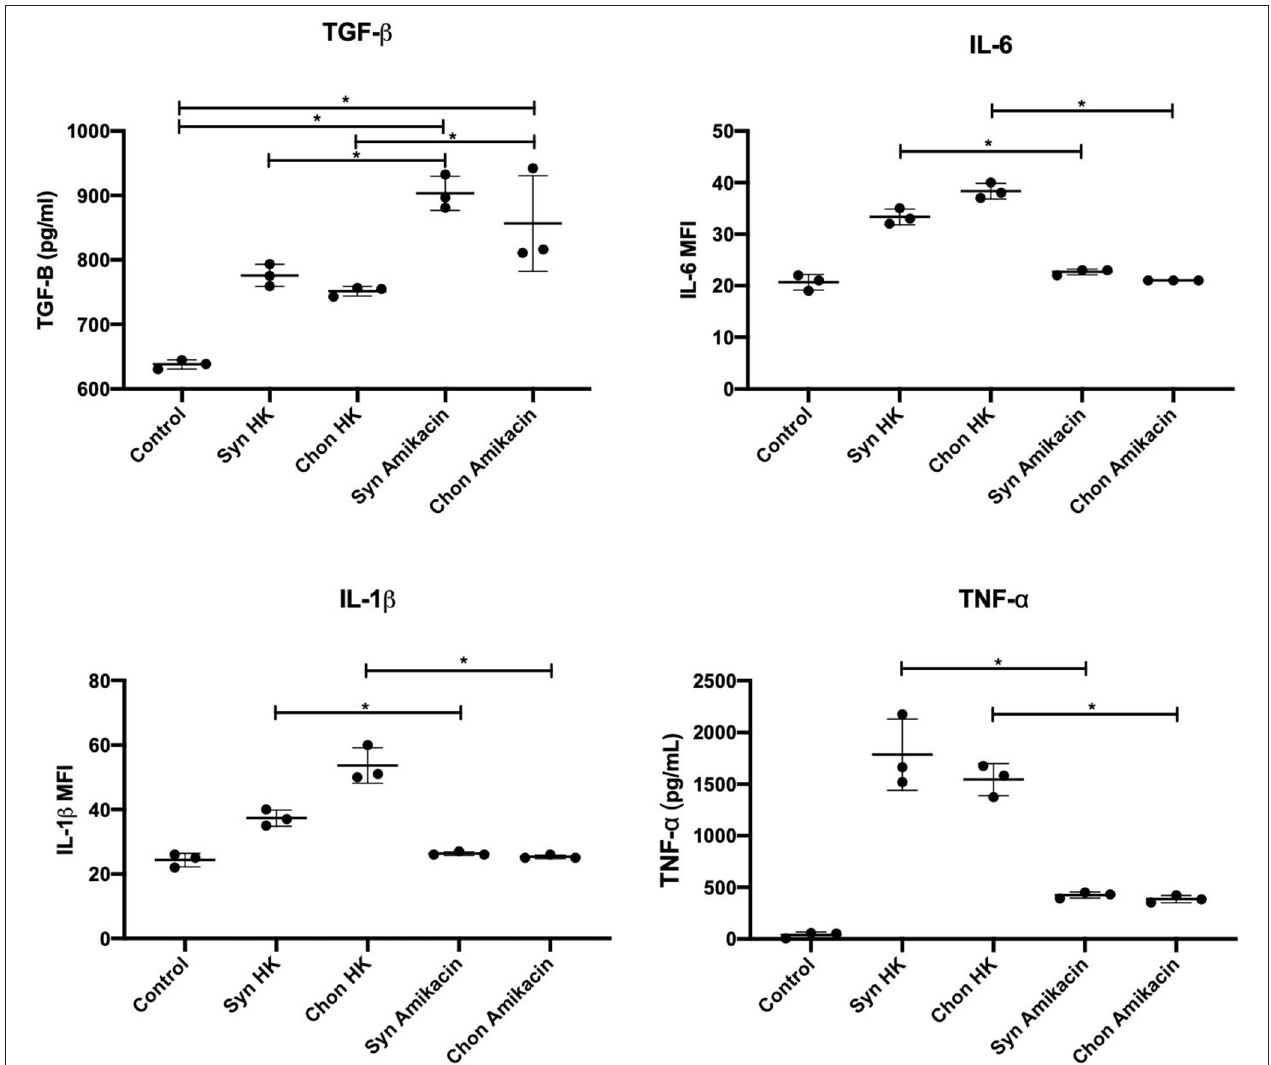
FIGURE 6 | Efferocytosis and cytokine suppression assays quantifying IL1- β , IL-6, TNF- α , and TGF- β 1 in macrophage culture media after incubation with equine synoviocytes and chondrocytes killed by induced apoptosis (25 mg/ml amikacin) or necrosis (heat killed, HK ). Data were evaluated by two-way ANOVA. Significance was assessed at * p ≤